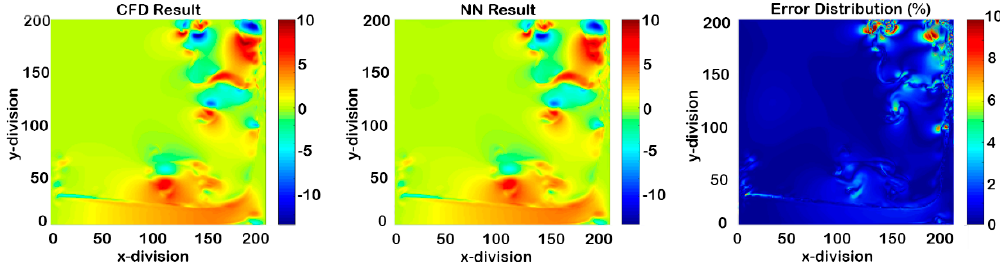
Figure 39. Cascading results of Model Ⅳ for X-direction-velocity at time-step 1050 (50 time-steps after deployment).